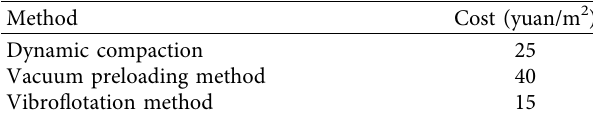
Table 3: Cost comparison of different